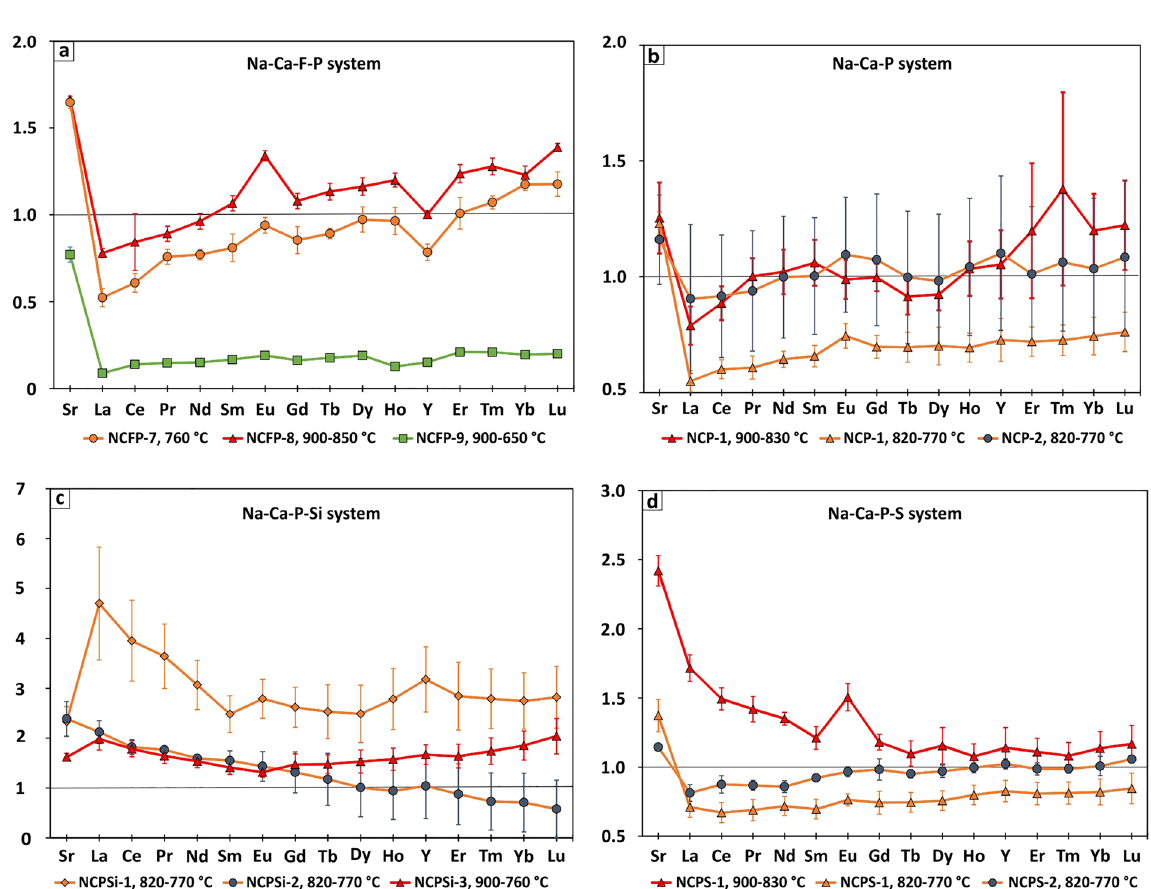
Figure 3. The average partition coefficients of REE with the standard deviation as error bars for